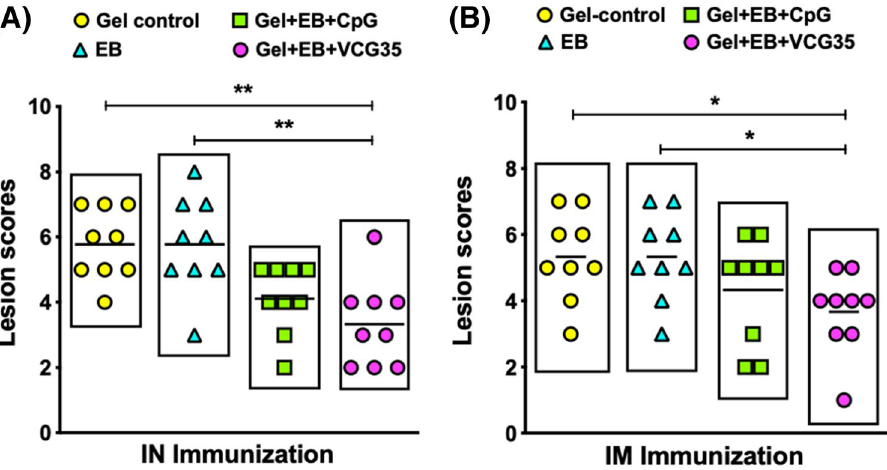
Figure 5. Comparison of lung and air sac pathological lesions. Groups of chickens immunized IN ( A ) or IM ( B ) as described above were challenged intranasally with 1 × 10 8 IFU of live C. psittaci 2 weeks after the booster immunization. Chickens from each group (9/group) were euthanized 2 weeks post challenge, and harvested lungs and air sacs were macroscopically examined for pathological lesions and scored. The presence or absence of lesions and lesion severity were scored according to the criteria described in the text and the calculated total group severity score (the sum of the scores for lungs and air sacs) was recorded for each chicken. Differences between experimental groups were compared by One-way ANOVA with Tukey’s post multiple comparison test at p * < 0.05 and p ** <